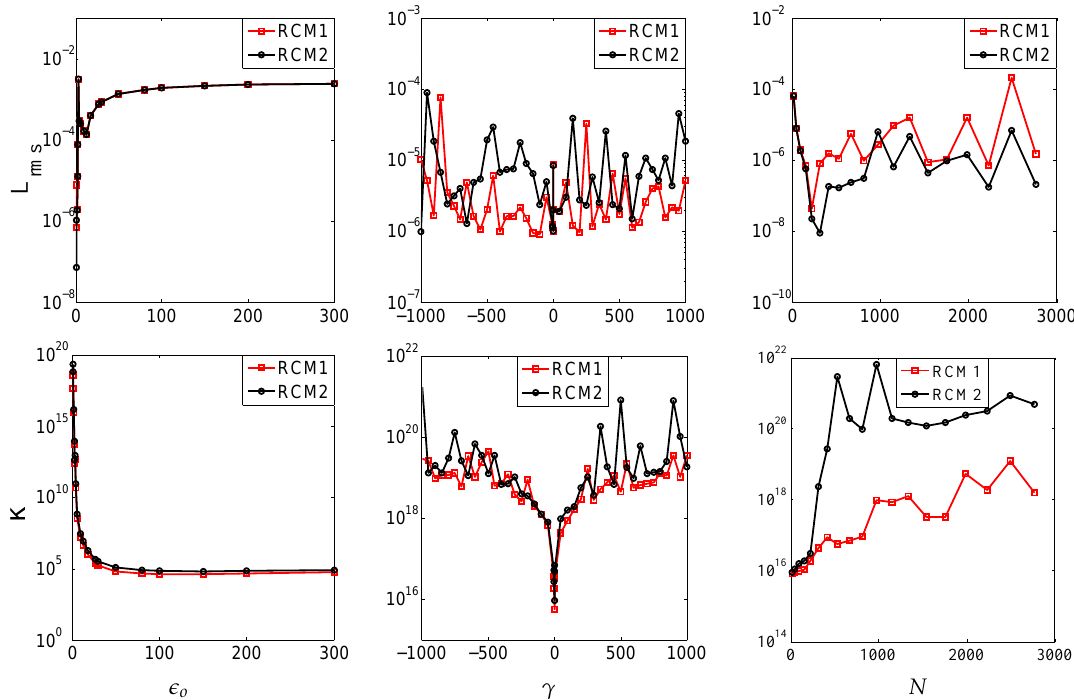
Figure 3. Test Problem 1, accuracy and κ versus (cid:101) o , γ , and N : ˆ Γ 1 = 60, ˆ Γ 2 = 16, γ = 1, (cid:101) o = 2, and N = 94 when its influence is